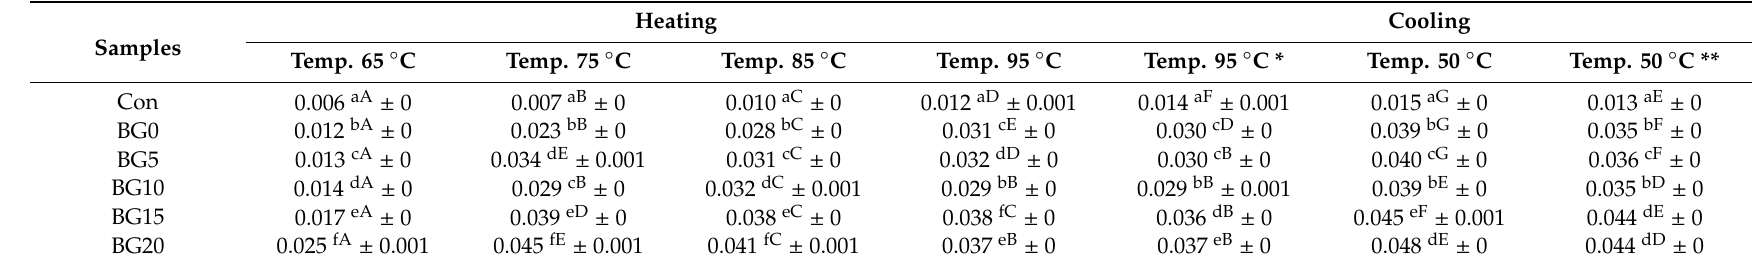
Table 4. The results of the tests of the apparent viscosity of pasta (Pa s) using the shear rate gradient of 1000 s − 1